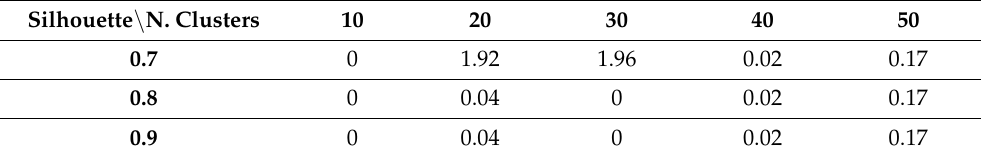
Table 5. Clustering performance in terms of silhouettes using the reduced dataset with PCA applied to normalized data. Silhouette \ N. Clusters